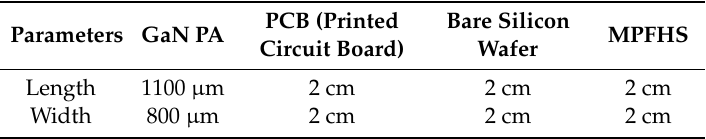
Figure 1. ( a ) Three-dimensional model of a GaN power amplifier mounted onto plates (not to scale), ( b ) Cross-sectional view of the GaN chip with integrated MPFHS (micro-pin fin heat sink) (not to scale). Table 1. Parameters of the equipment.